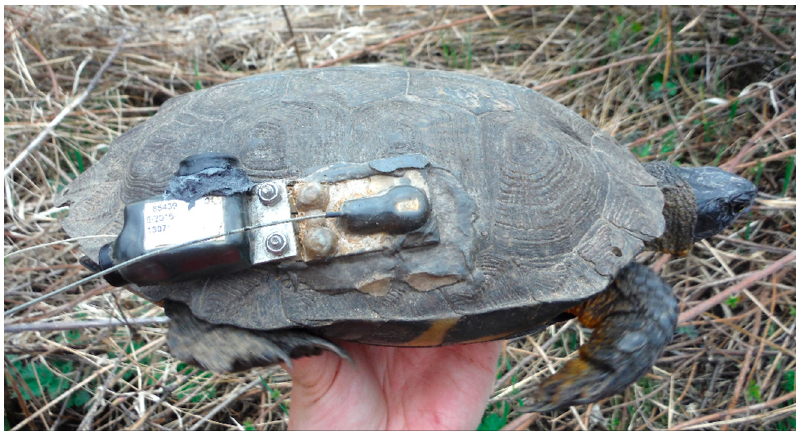
Figure 1. Wood turtle ( Glyptemys insculpta ) in northeastern Minnesota, USA, with epoxied very high frequency (VHF) transmitter, global positioning system (GPS) receiver, and iButton temperature logger.